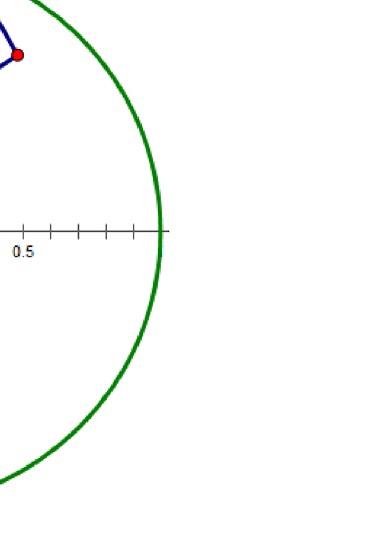
Figure 2. Polar coordinates of time